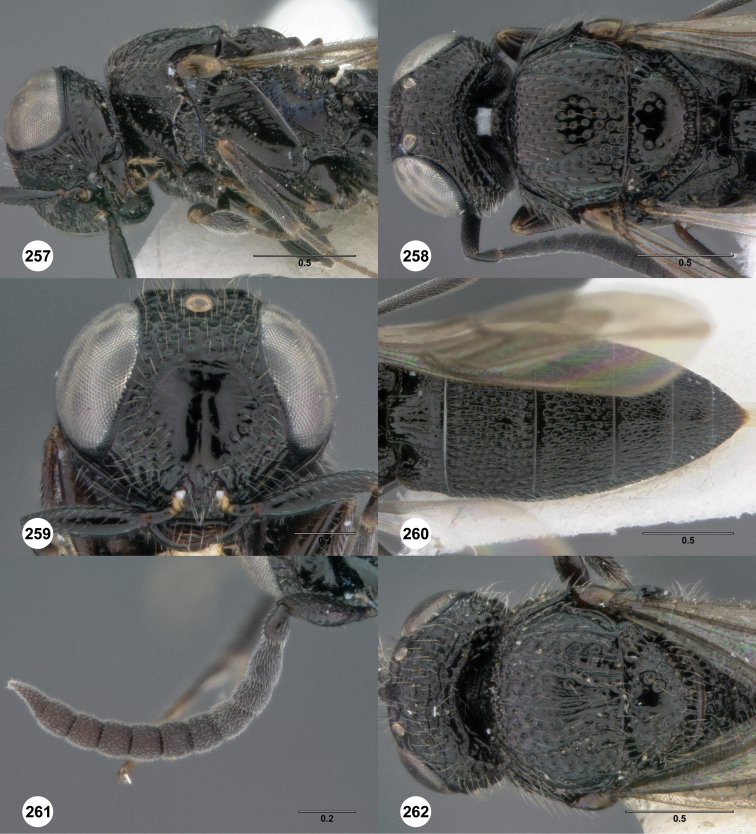
Oxyscelio pollicis sp. n., paratype female (OSUC 439551) 257 Head and mesosoma, lateral view. Paratype female (OSUC 439550) 258 Head and mesosoma, dorsal view 259 Head, anterior view 260 Metasoma, dorsal view. Paratype male (OSUC 439553) 261 Antenna 262 Metasoma, dorsal view. Morphbank77